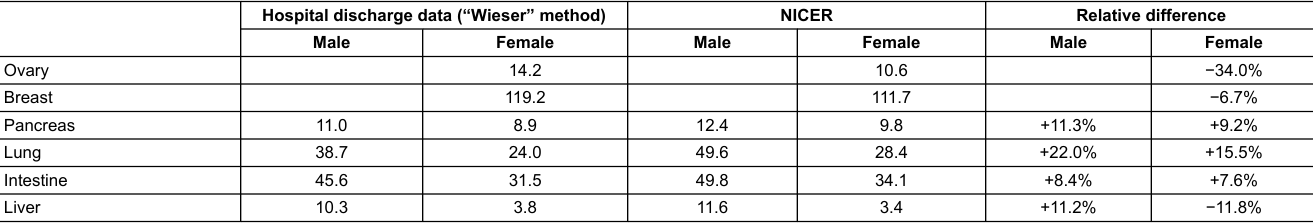
Table 1: Age-standardised incidence rates * of selected cancer sites for the period 2011–2014 according to hospital discharge data and NICER data, with their relative difference. Hospital discharge data (“Wieser” method) NICER Relative